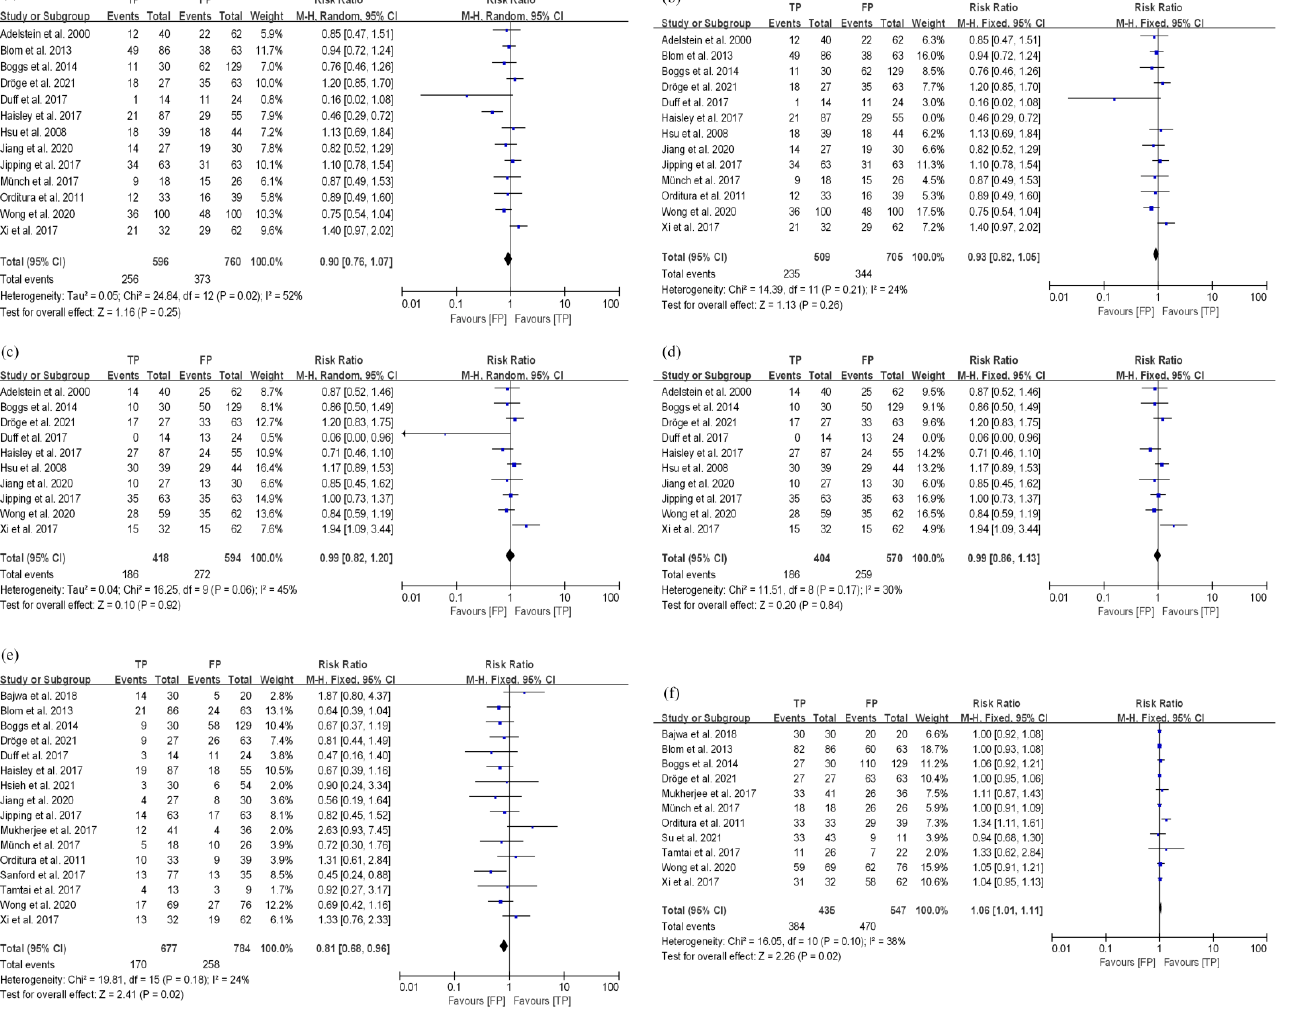
Figure 4. Analysis of curative effects of TP and FP groups in EC patients treated with nCRT. ( a ) 3-year OS; ( b ) 3-year OS after correction; ( c ) 3-year PFS; ( d ) 3-year PFS after correction; ( e ) pCR; ( f ) R0